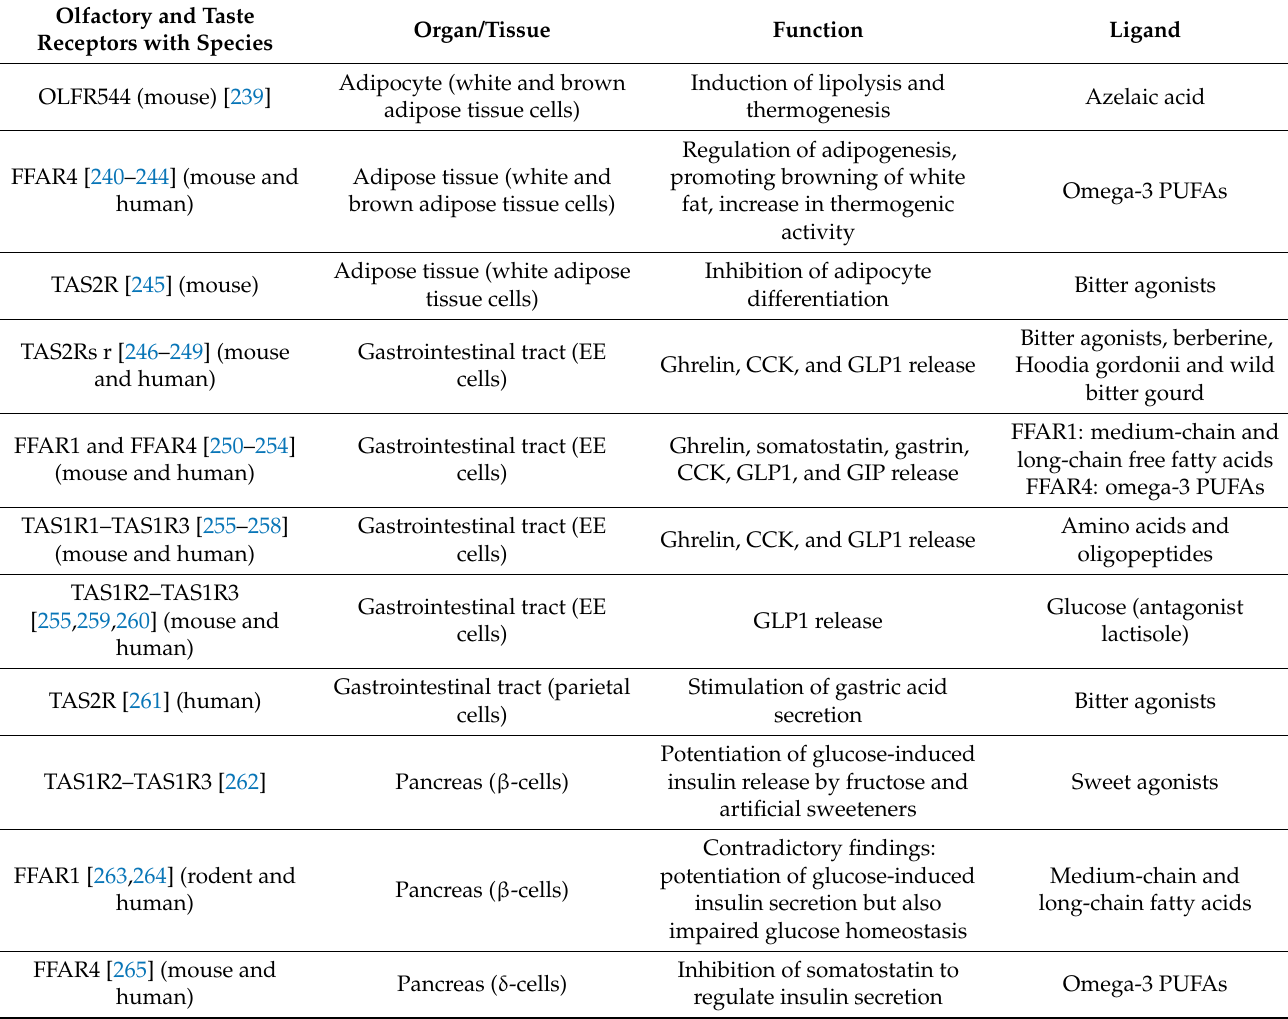
Table 2. Taste and olfactory receptors in organs and tissues relevant to metabolic diseases.